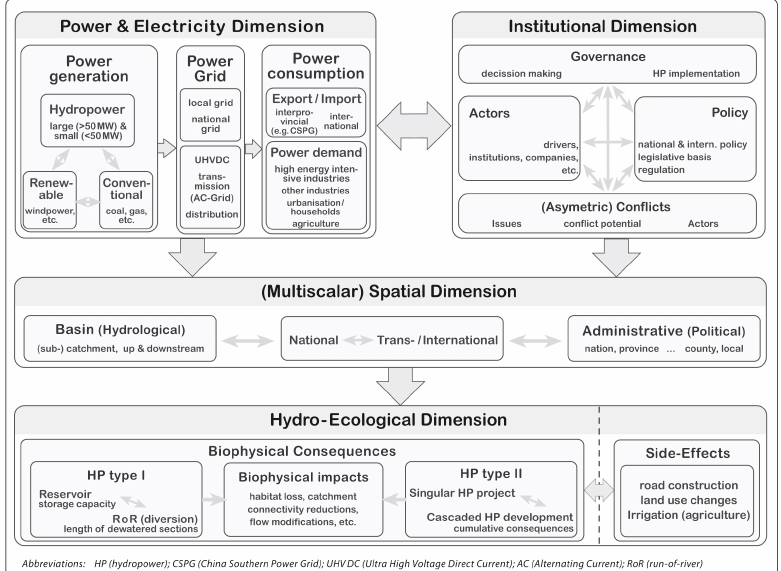
Figure 2. Modified conceptual map of Magee’s powershed approach [10].